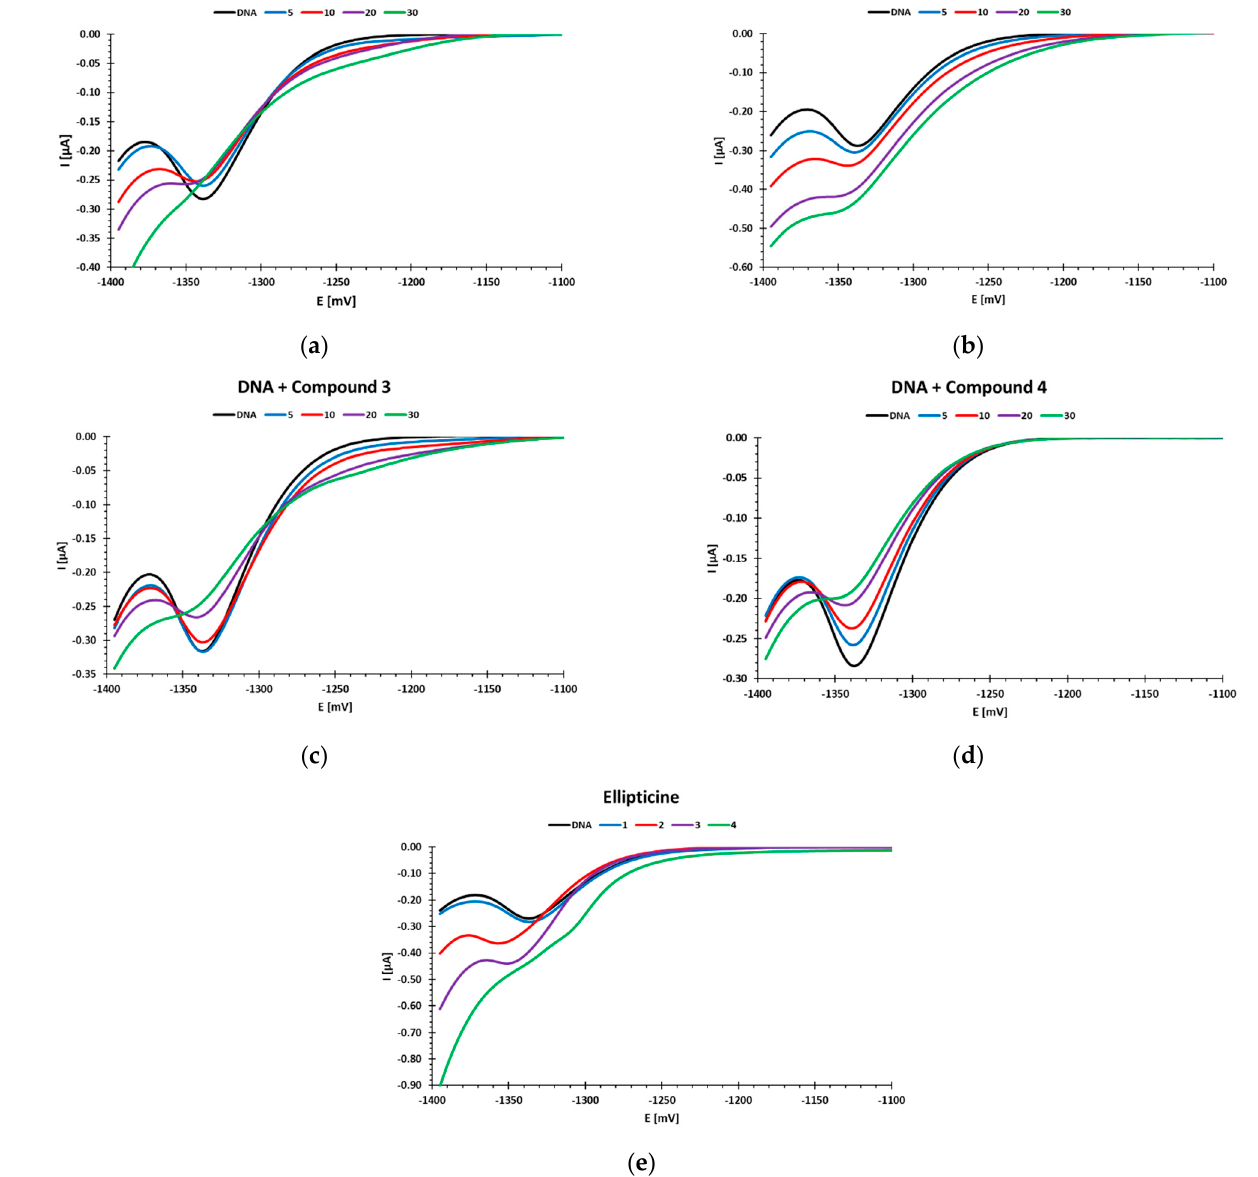
Figure 5. Polarographic curves showing the dependence of the DNA reduction peak on the concentration of the tested compounds: ( a ) compound 1 ; ( b ) compound 2 ; ( c ) compound 3 ; ( d ) compound 4 ; ( e ) ellipticine. Concentration of compounds 1–4 varied from 5–30 µ M and ellipticine from 1–4 µ M and is shown in legend of each subfigure in µ M, DNA concentration was constant (25 µ